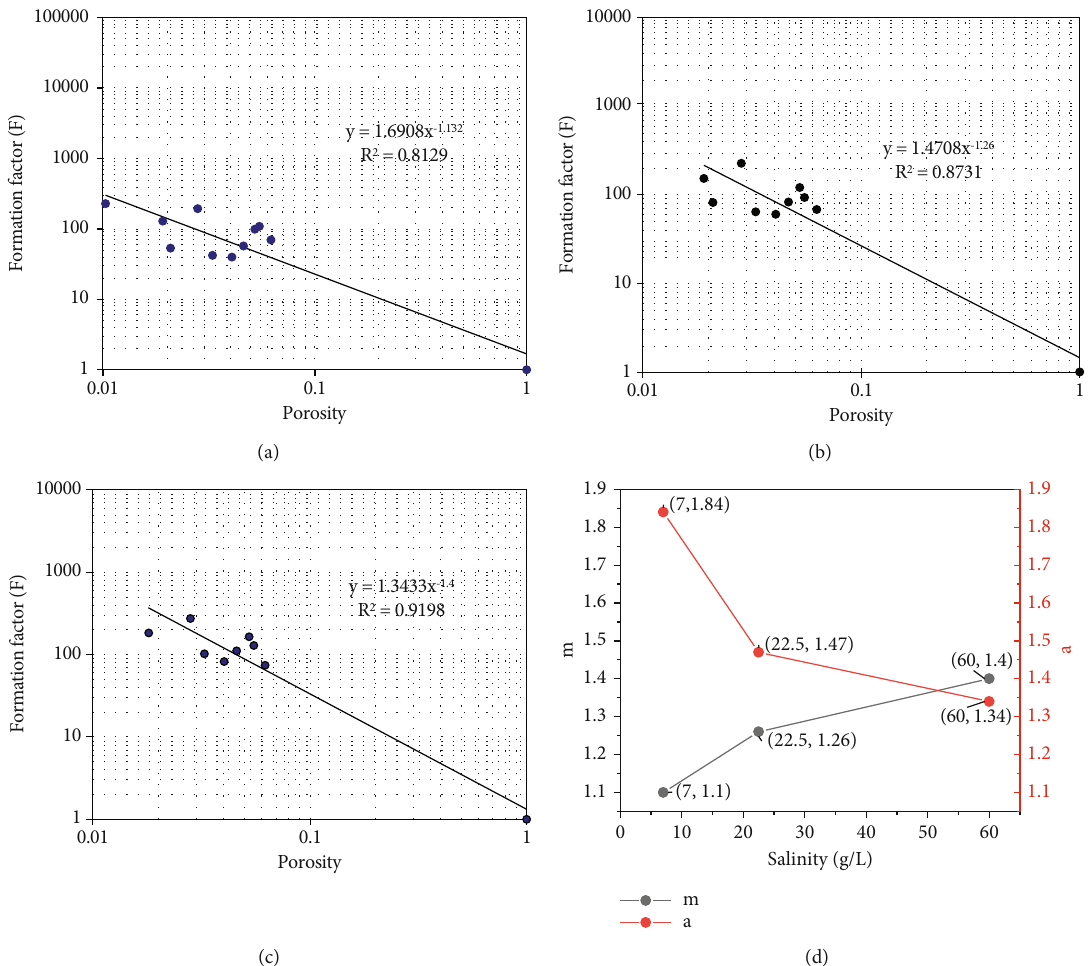
Figure 5: Determination of m and a from log porosity versus log F under di ff erent salinities. (a) 7000 ppm; (b)22500 ppm; (c) 60000 ppm; (d) comparison of m and a .